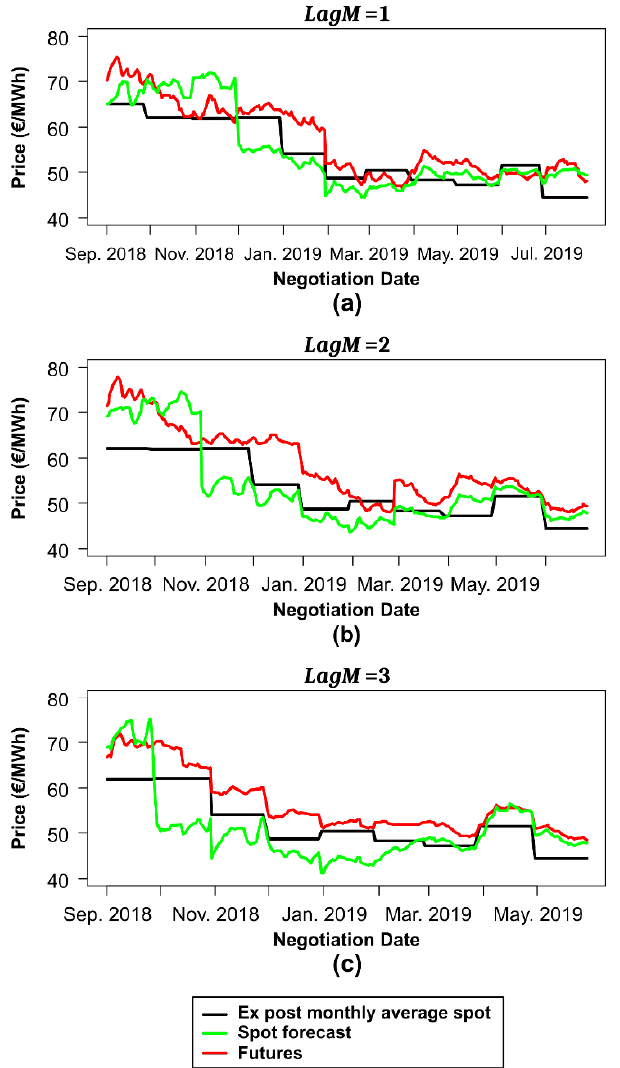
Figure 2. Futures, spot forecast and ex post monthly average prices for the delivery months in the testing period for di ff erent maturity ( LagM ) values: ( a ) for LagM = 1, ( b ) for LagM = 2 and ( c ) for LagM = 3.